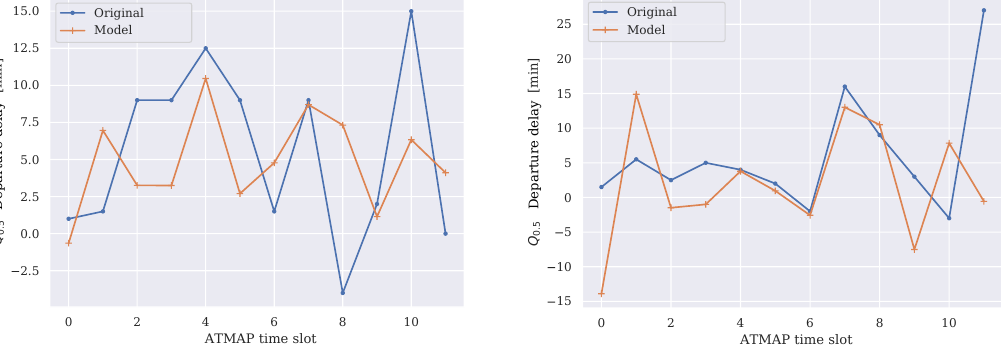
Figure 8. Forecast/prediction of DEP delay ( Q 0.5 ) for 2 example days in HAM 2013 for a forecast horizon of 6 h (corresponding to 12 ATMAP